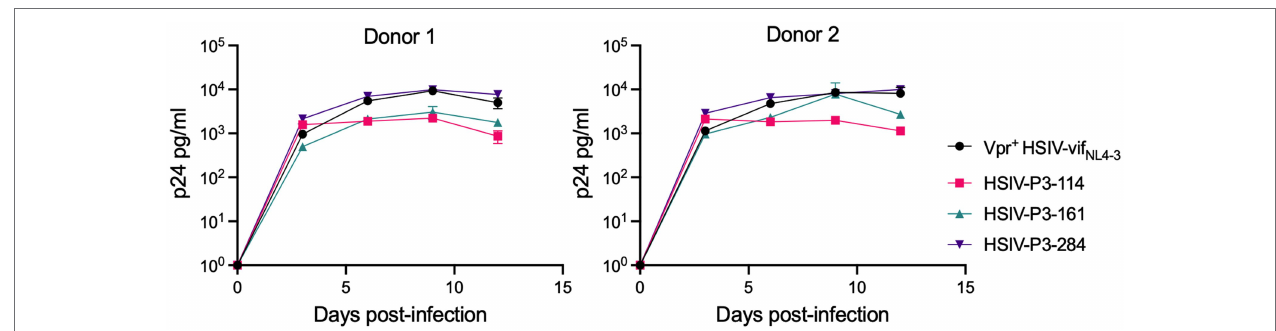
FIGURE 8 | HSIV-P3 IMCs replicate in PTM peripheral blood mononuclear cells (PBMCs). PBMCs from different donor PTMs were activated with concanavalin A for 3 days and maintained in media containing IL-2 (40 U/ml) for 2 days. Cells were then infected in duplicate with HSIV-P3 IMCs or parental Vpr + HSIV-vif NL4-3 virus at an MOI of 0.01, and supernatants were assayed for p24 by ELISA every 3–4 dpi.